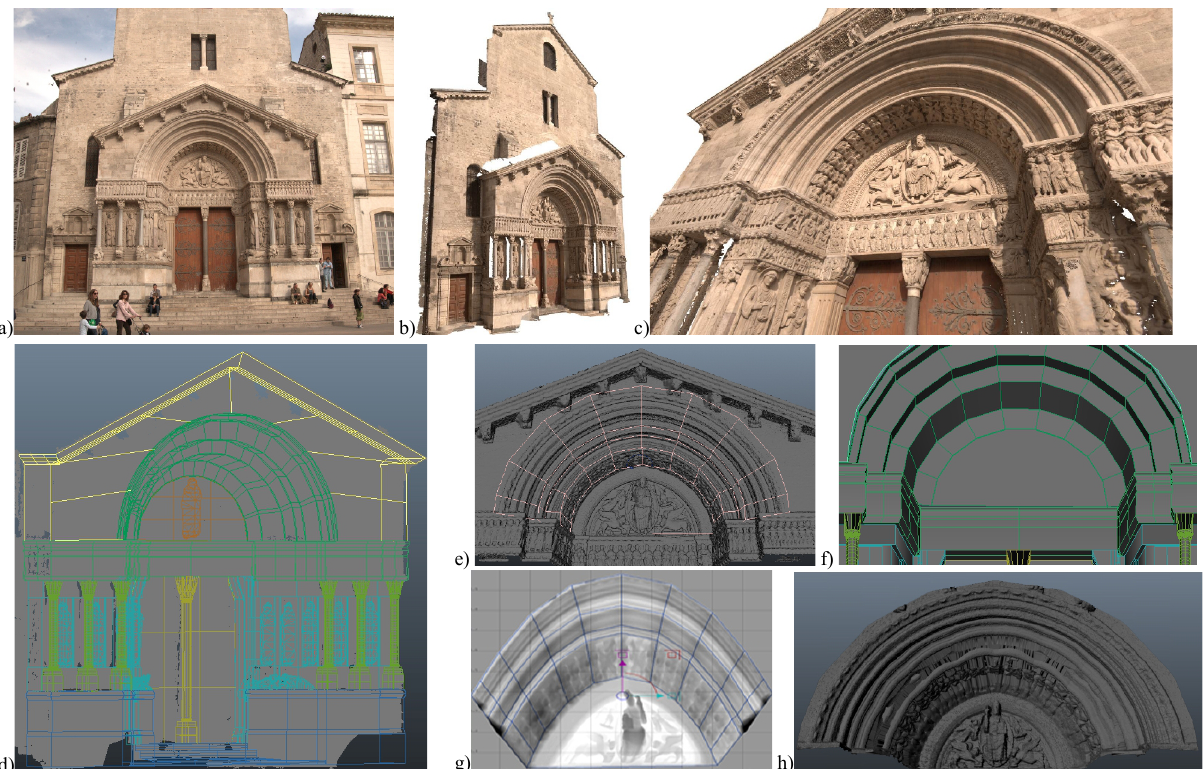
Figure 3: The façade of Saint-Trophime church (a) reconstructed using ca 90 images. The image matching procedure produced a dense cloud with ca 45 million points (b, c). The primitive-based modeling result on the entire façade (d) and a closer view on the upper arch (e, f). The displacement map (g) and the final primitive-based model